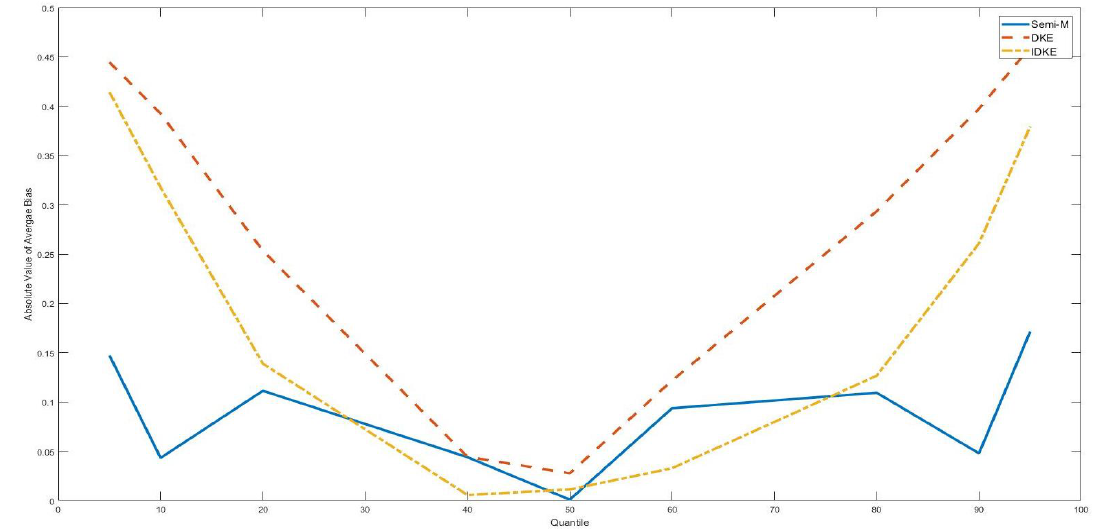
Figure 1. Average bias with γ 0 as various quantiles of the threshold variable, DGP 2, n = 100. This figure shows absolute values of the average bias with the true threshold level being several quantiles of the threshold variable (5th,10th,20th,40th,50th,60th,80th,90th,95th). The simulation is based on DGP 2. The sample size is 100.